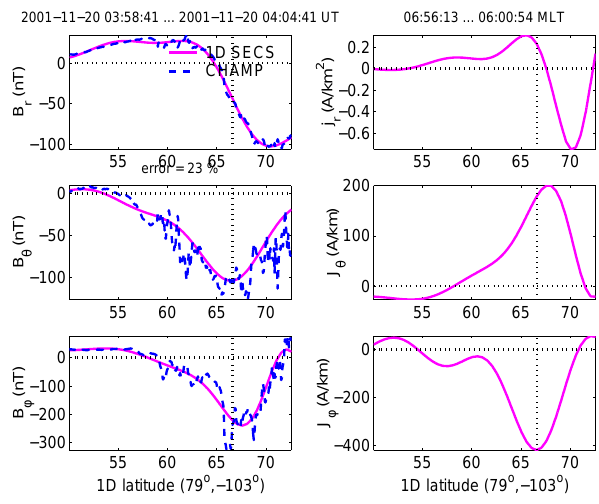
Fig. 7. The three components of the magnetic field ( B r , B θ , B φ ) and current density ( j r , J θ , J φ ) as a function of the 1D latitude on 20 November 2001, at 03:59–04:04 UT. The pole of the 1D system is located at 79 ◦ latitude and − 103 ◦ longitude. J φ is determined from B r , and j r and J θ from B φ . The 1D SECS B θ results from the B r fit and has an error of 23%.